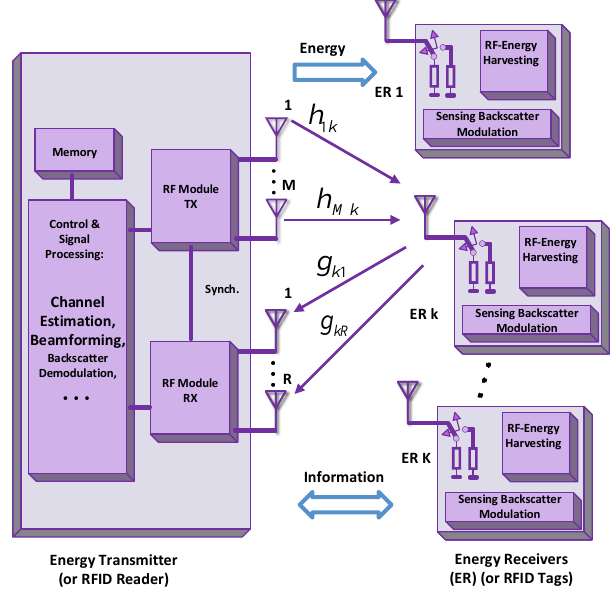
Figure 31. Efficient power transfer in